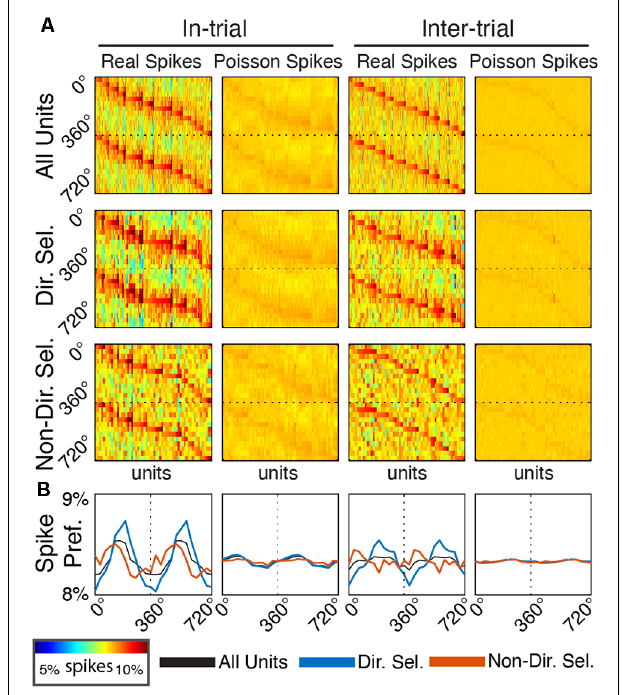
FIGURE 7 | Single unit entrainment occurs at preferred delta phases specifically for directionally-selective units. (A) Spike-phase histograms for functionally-defined single unit populations and surrogate Poisson-distributed spike trains. Each column within the individual phase histograms represents a single unit. Colors indicate the percentage of spikes within a phase bin (12 bins from 0 ◦ to 360 ◦ , repeated to 720 ◦ for clarity). Units are sorted by their preferred phase separately for each plot. (B) Mean spike-phase histograms for each unit population and firing rate-matched